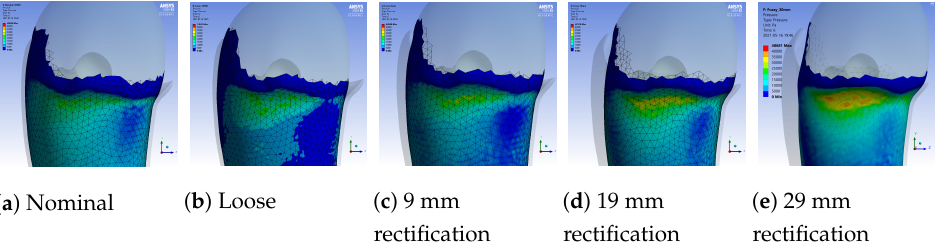
Figure 12. Regional pressure values in the proximal posterior region of the stump for different